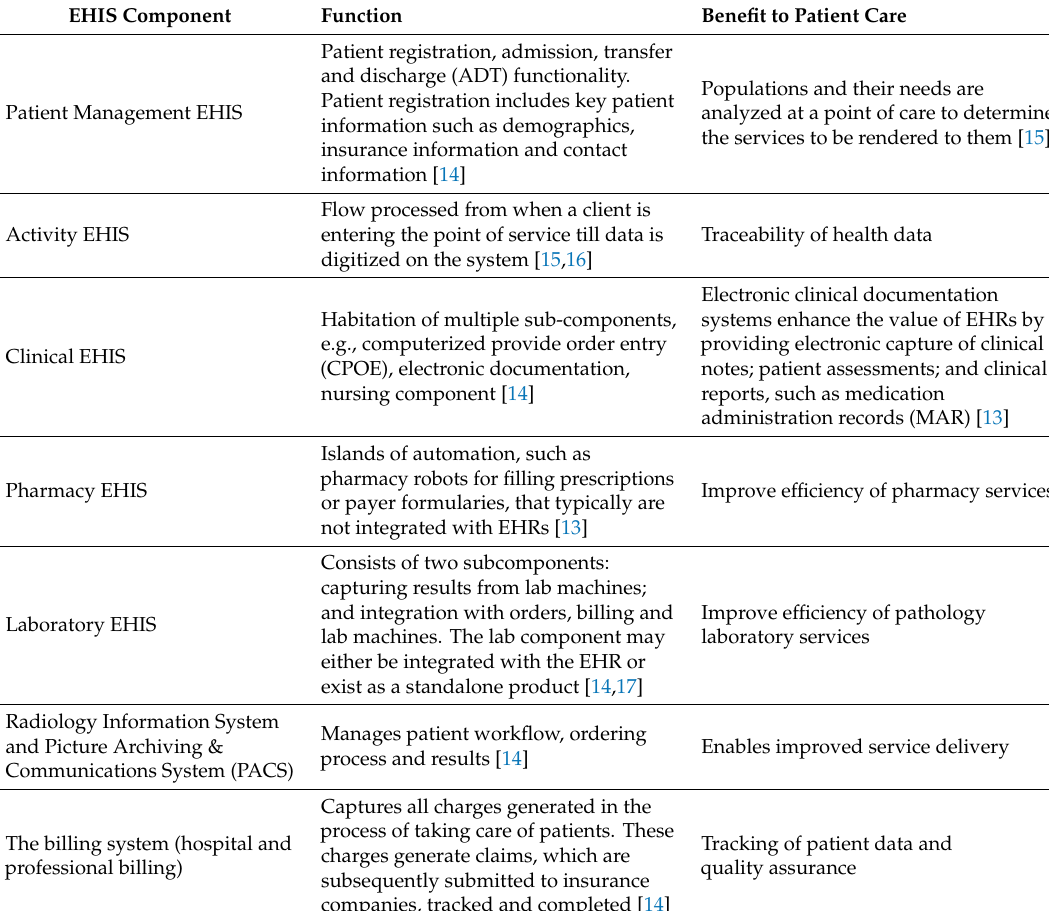
Table 1. Description of electronic health record (EHR) components, purposes within the electronic health system and patient care by National Institutes of Health National Center for Research Resources. EHIS